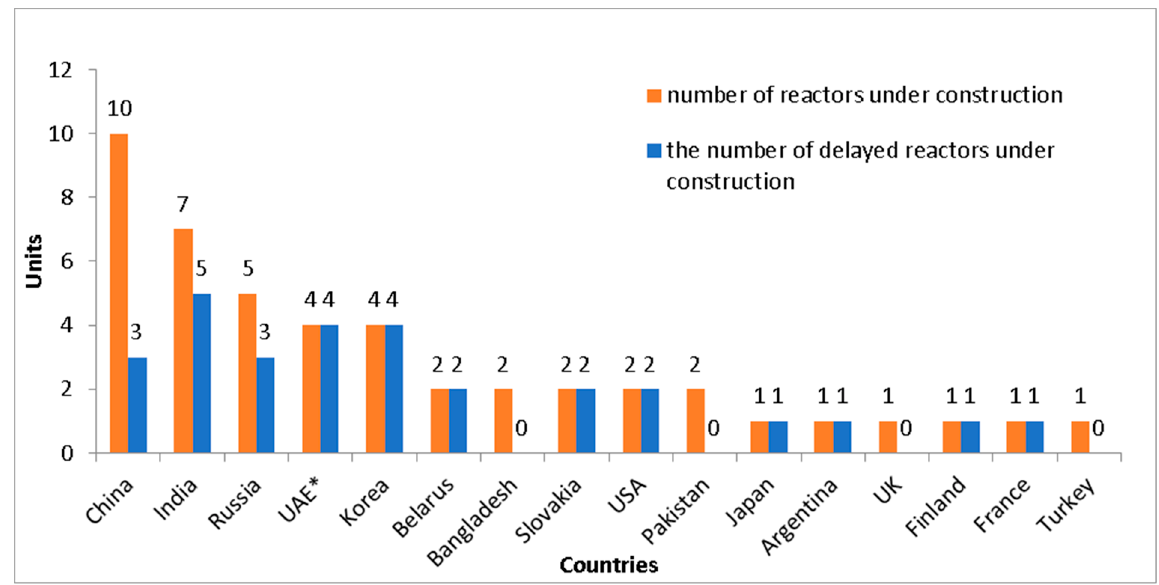
Figure 1. Number of nuclear reactors in selected countries and construction delays—own study based on [1,38–40]. * United Arab